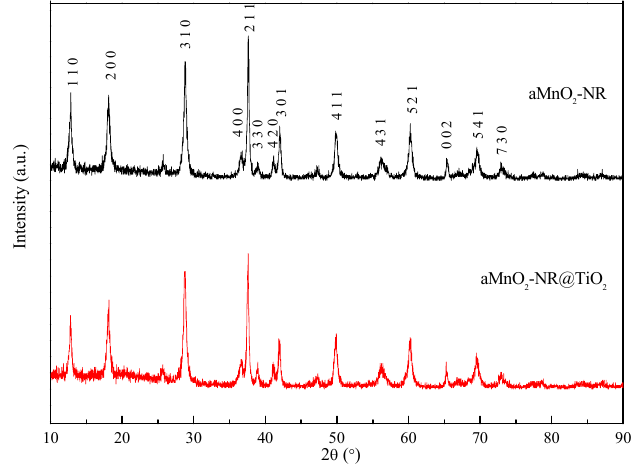
ff ractometer (XRD) patterns of α MnO